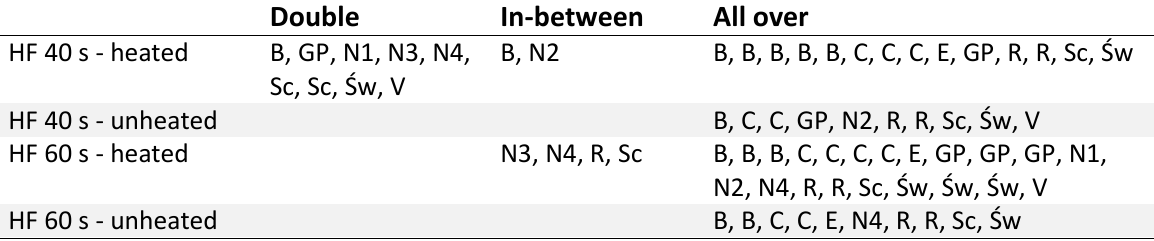
Figure 2. Experimental points after 40 seconds HF. Upper row left: double patina (heated); upper row right: in- between patina (heated); middle row: white patina (heated); lower row: white patina (unheated) (photo D. Fennema). Table 2. Results of experiments with hydrofluoric acid. Abbrevations: B=Bergerac; C=Charente; E=Eben- Emael; GP=Grand-Pressigny; N1/2/3/4=Northsea 1/2/3/4; R=Ryckholt; Sc=Scandinavian; Św= Świeciechów;